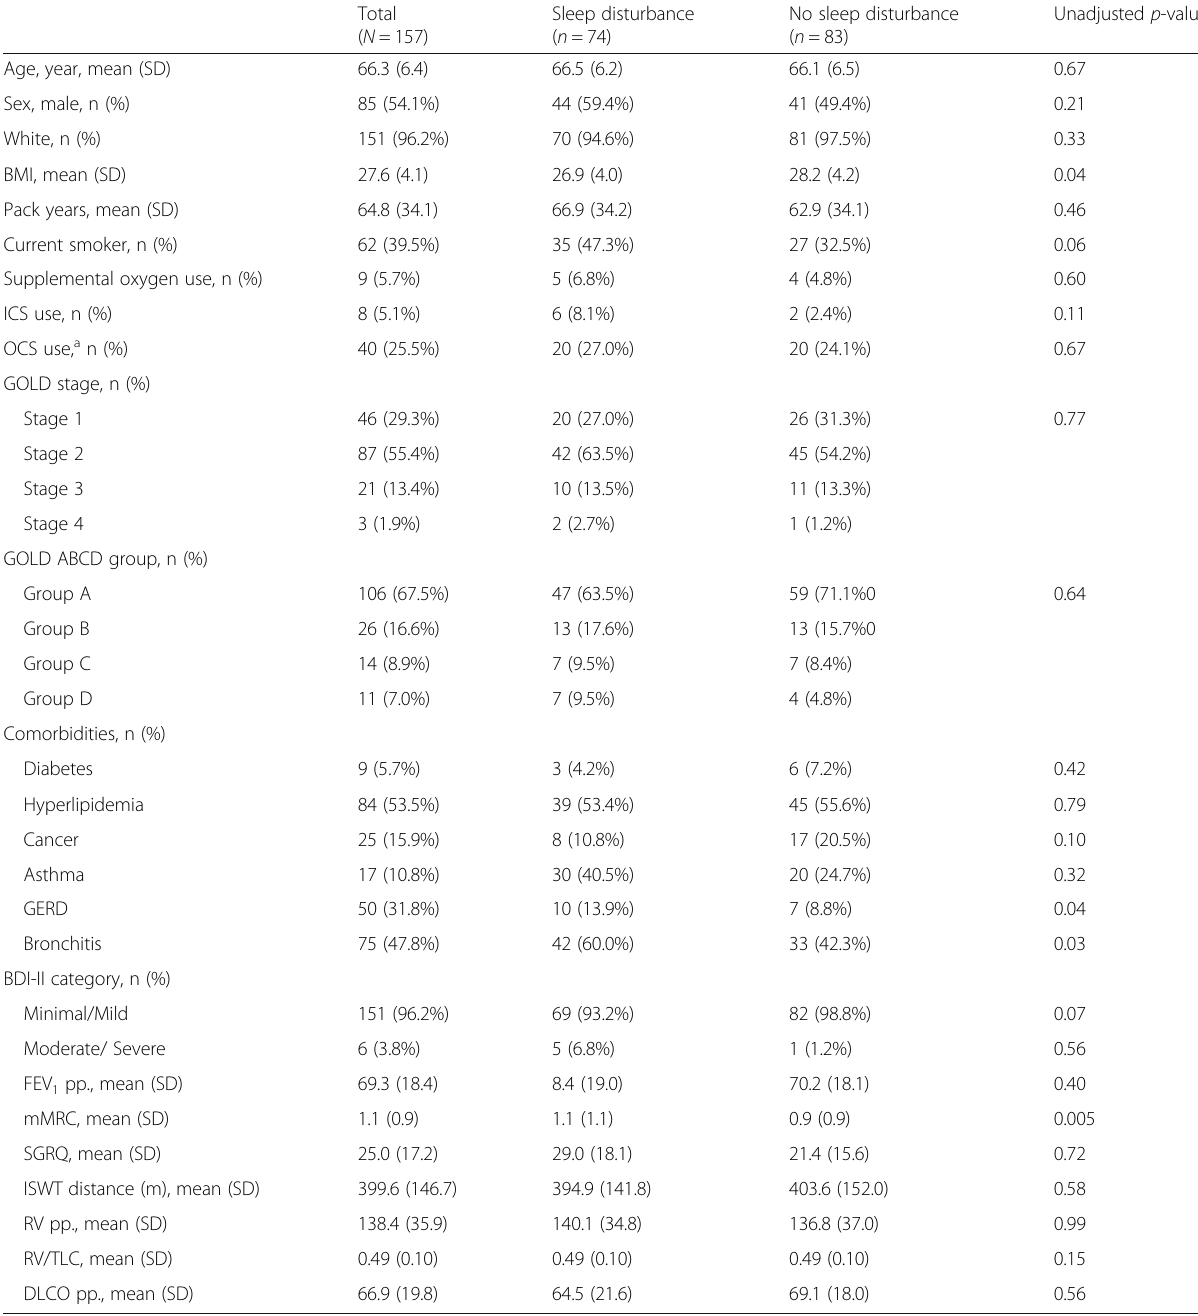
Table 1 Participant characteristics at baseline according to sleep disturbance